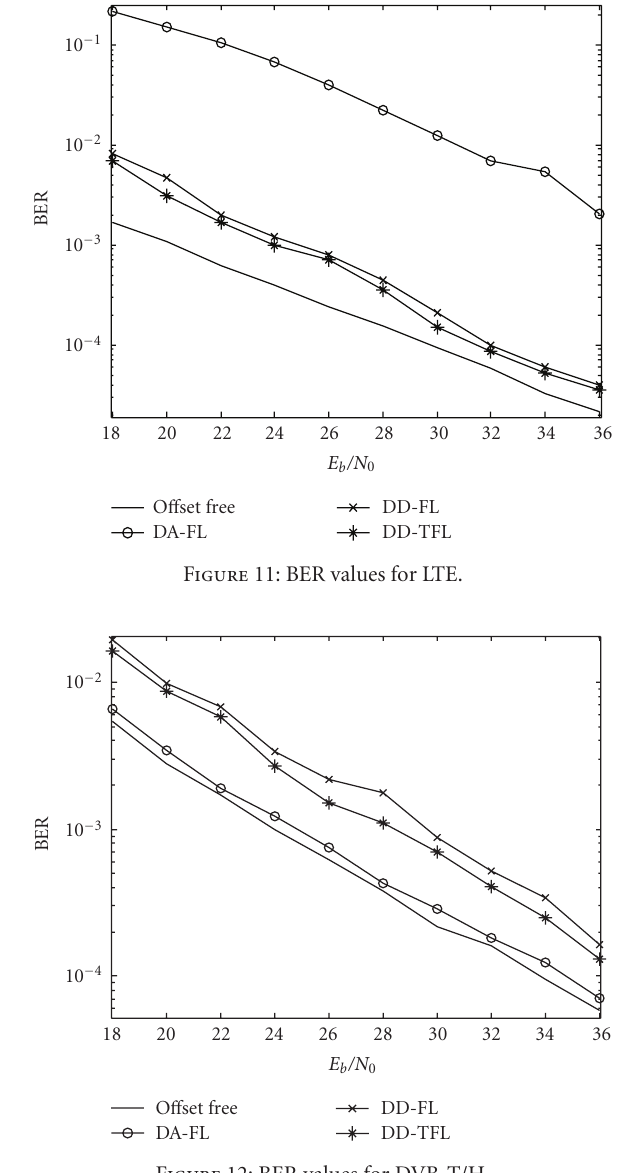
Figure 12: BER values for DVB-T/H.